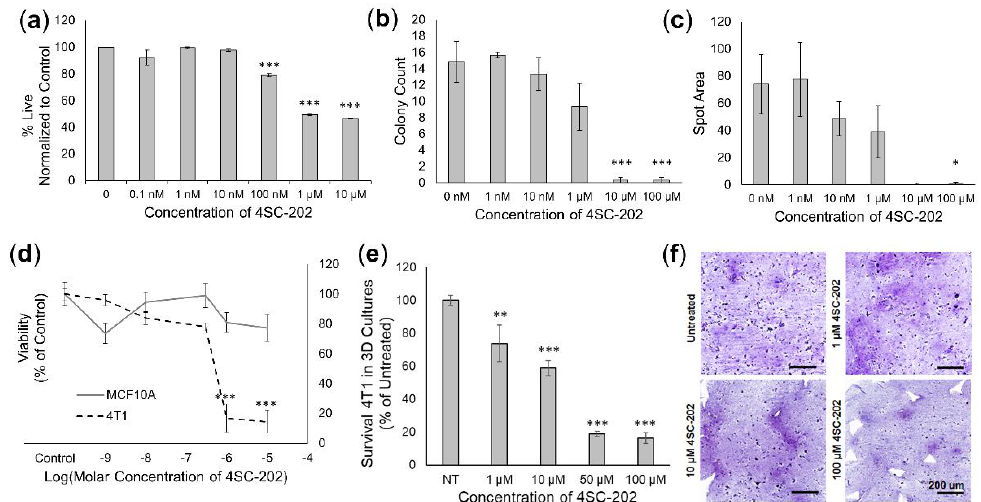
Figure 2. 4SC-202 is cytotoxic and cytostatic in metastatic TNBC murine cell line 4T1. ( a ) Viability of 4T1 cells measured by a Sytox Green live fluorescence assay indicates 4SC-202 is significantly cytotoxic at concentrations ranging from 100 nM to10 µM, measured 72 h after treatment for n = 8 biological replicates. ( b ) 4SC-202 is cytotoxic to colony number formation after 6 days exposure at concentrations ranging from 10 to 100 µM, and ( c ) significantly reduces the area of colonies at 100 µM indicating a cytostatic effect ( n = 3 biological replicates except 0, 100 µM where n = 6 biological replicates). ( d ) While significantly cytotoxic to 4T1 spheroids at 1-10 µM, 4SC-202 is not cytotoxic to normal breast epithelial MCF10A spheroids for n = 6 replicates. ( e ) Survivability of 4T1 in a three-dimensional scaffold model as measured by flow cytometry indicates 4SC-202 is significantly cytotoxic to 4T1 at concentrations ranging from 1 to 100 µM for n = 3 scaffold experiments with 3 technical replicates. ( f ) H and E-stained images of sectioned 3D scaffold models indicates a reduced number of nuclei following exposure of 4T1 to 4SC-202 at concentrations ranging from 1 µM to100 μM. Significance relative to control group was determined using ANOVA with a post hoc Dunnett’s test where adj p < 0.05 (*); adj p < 0.01(**); adj p < 0.001(***). Error bars indicate the standard error of the mean (SEM).